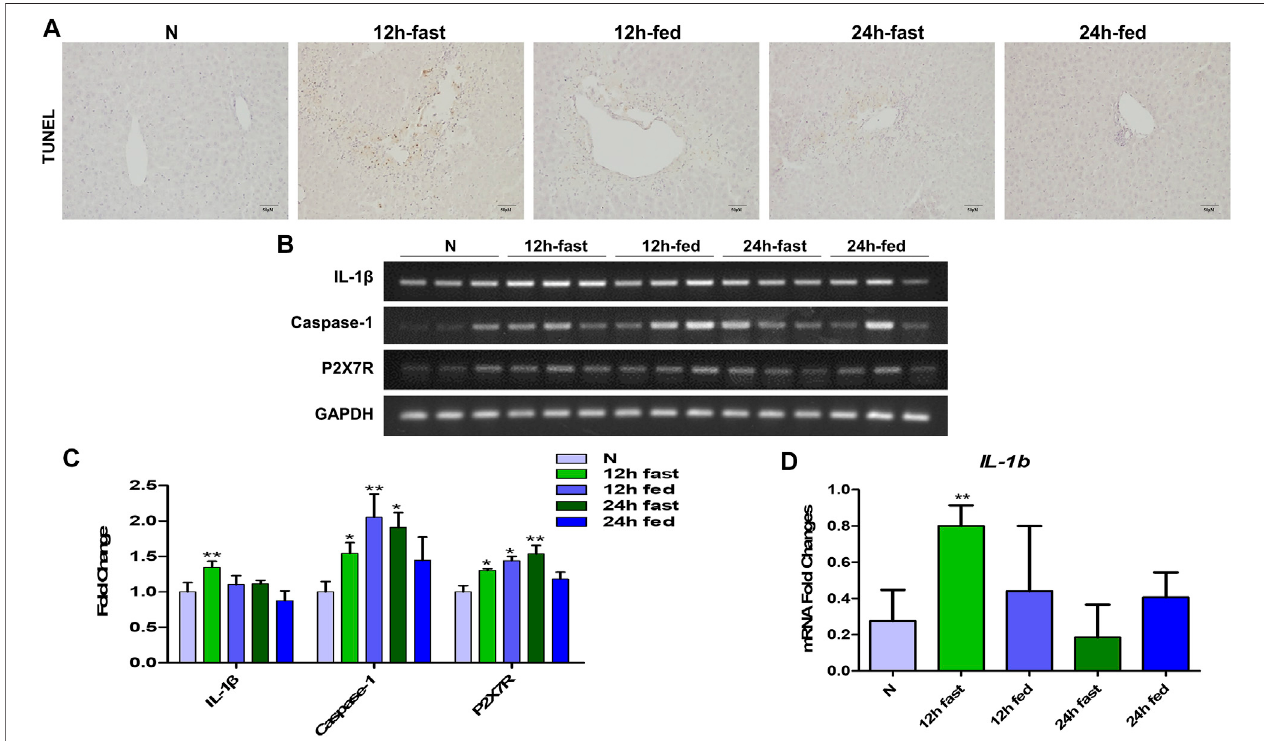
FIGURE4| Effect offasting factors onthe invivo modelofliver injuryinducedbyAPAP.C57B/6mice were randomly divided into fi vegroups: normal group, APAP (300 mg/kg)12 hfastingornotfastinggroupand24 hfastingornotfastinggroup. (A) TUNELstaining,theimagewasmagni fi edby200 × . (B,C) mRNAexpressionofIL- 1 β , Caspase-1 and P2X7R and their relative expression levels relative to GAPDH. (D) (E) Real-time quantitative PCR results of IL-1 β . * p < 0.05, ** p < 0.01, *** p < 0.001, signi fi cantlydifferentfrom the normal group. One-way ANOVA followed byTukey ’ stest. Thedata are expressed as themean ± SDof fi ve independentassays with at least three